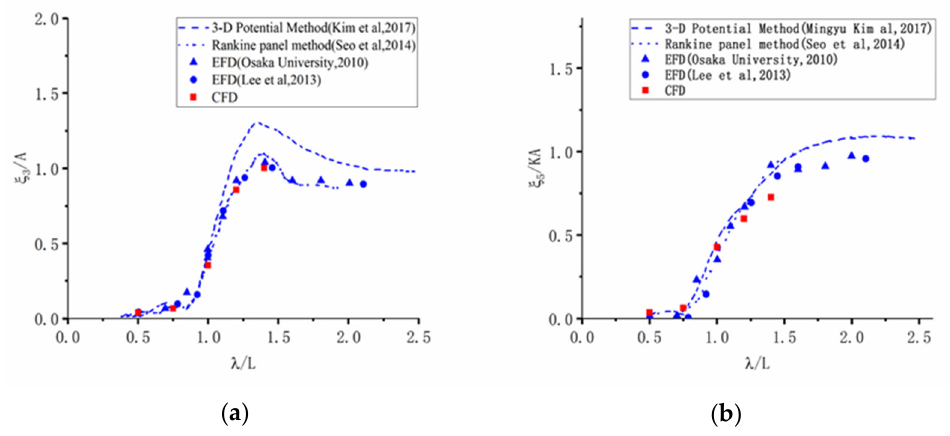
Figure 11. RAOs of KVLCC2 hull at V = 15.5 knots. ( a ) Heave; ( b )